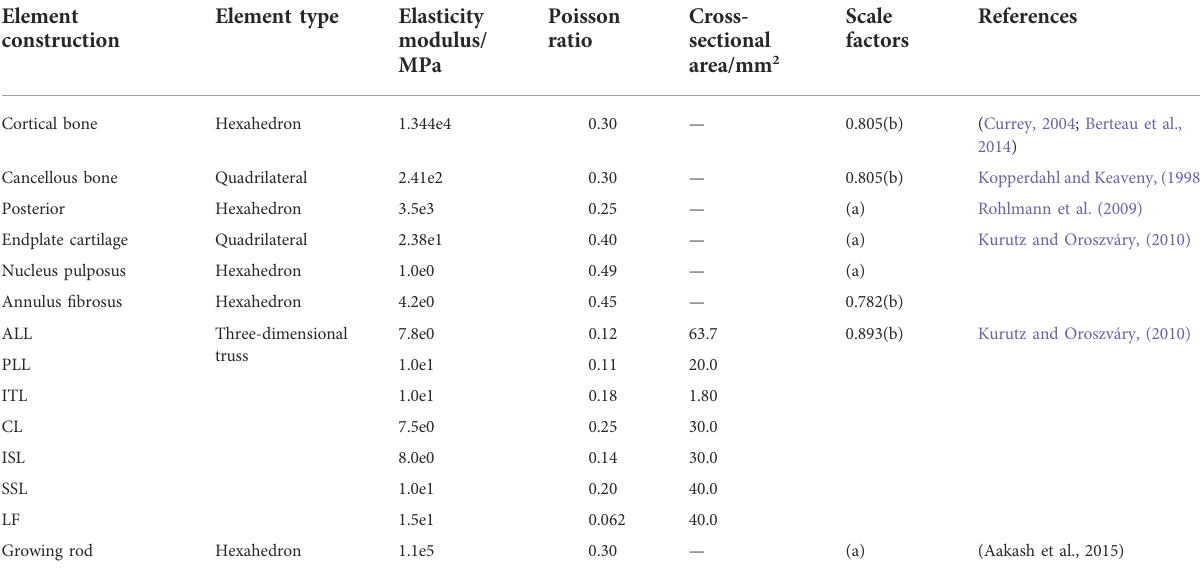
TABLE 1 Material properties in the present fi nite element